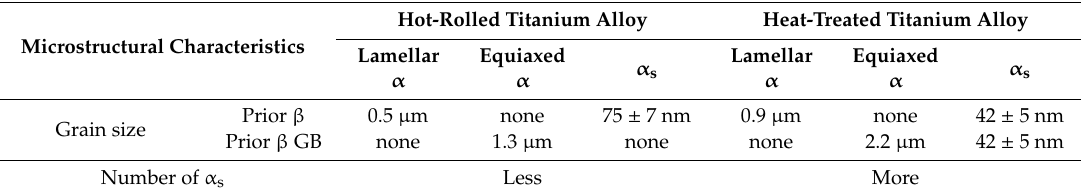
Table 2. Microstructural characteristics of the hot-rolled and heat-treated titanium alloys. GB: grain boundary.